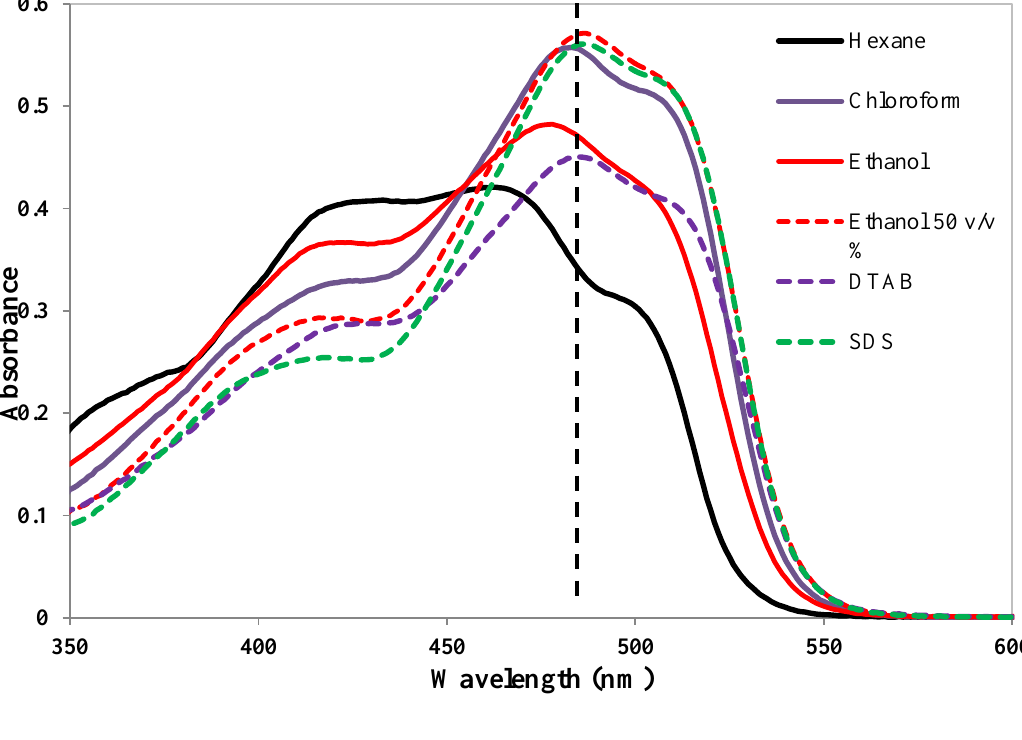
Figure 15. Absorption spectra of the dye C.I. Solvent Yellow 14 (Sudan I) in micellar solutions of DTAB and SDS and in different solvents. “Ethanol 50 v/v %” stands for equal volumes of water and